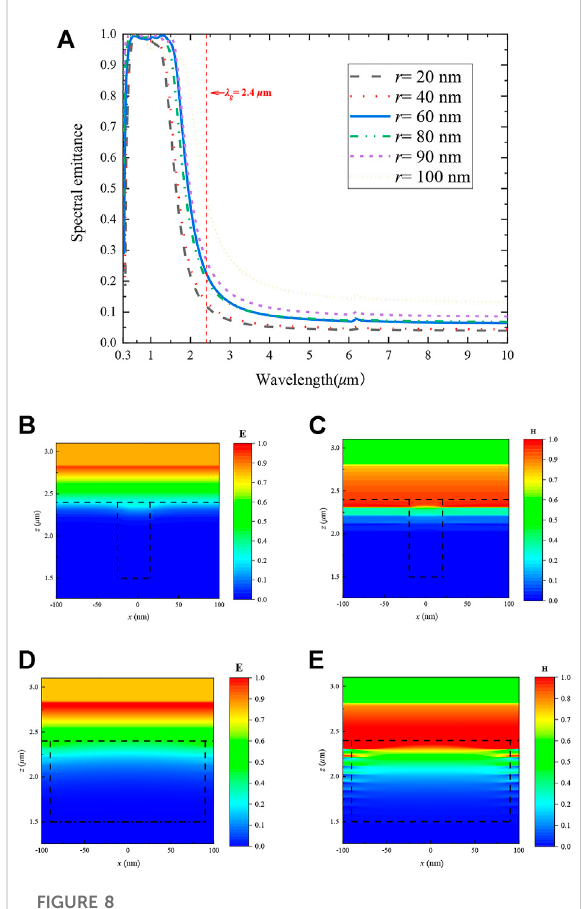
FIGURE 8 (A) Variation of structural spectral emittance with radius ( r = 20 nm, 40 nm, 60 nm, 80 nm, 90 nm, and 100 nm) for fi xed other parameters of the composite structure ( a = 200 nm, d M = 10 nm, d D = 80 nm, n c = 1, h = 900 nm). Normalized electromagnetic fi eld clouds of the composite structure at λ = 6 μ m for r = 20 nm (B) electric fi eld (C) magnetic fi elds and r = 90 nm (D) electric fi eld (E) magnetic fi elds.